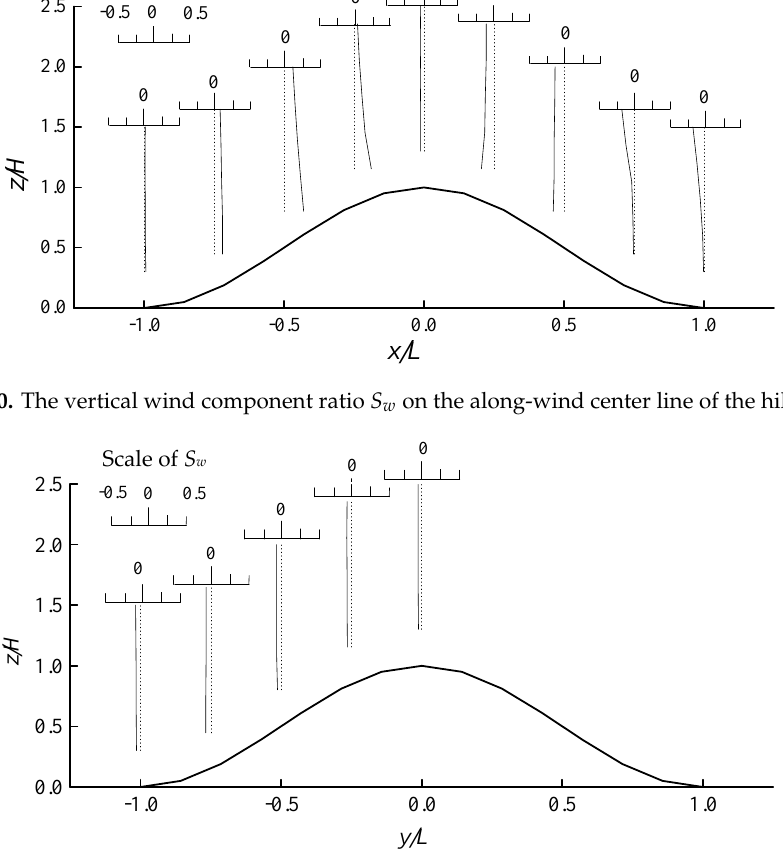
Figure 11. The vertical wind component ratio S w on the crosswind center line of the hill ( x = 0).